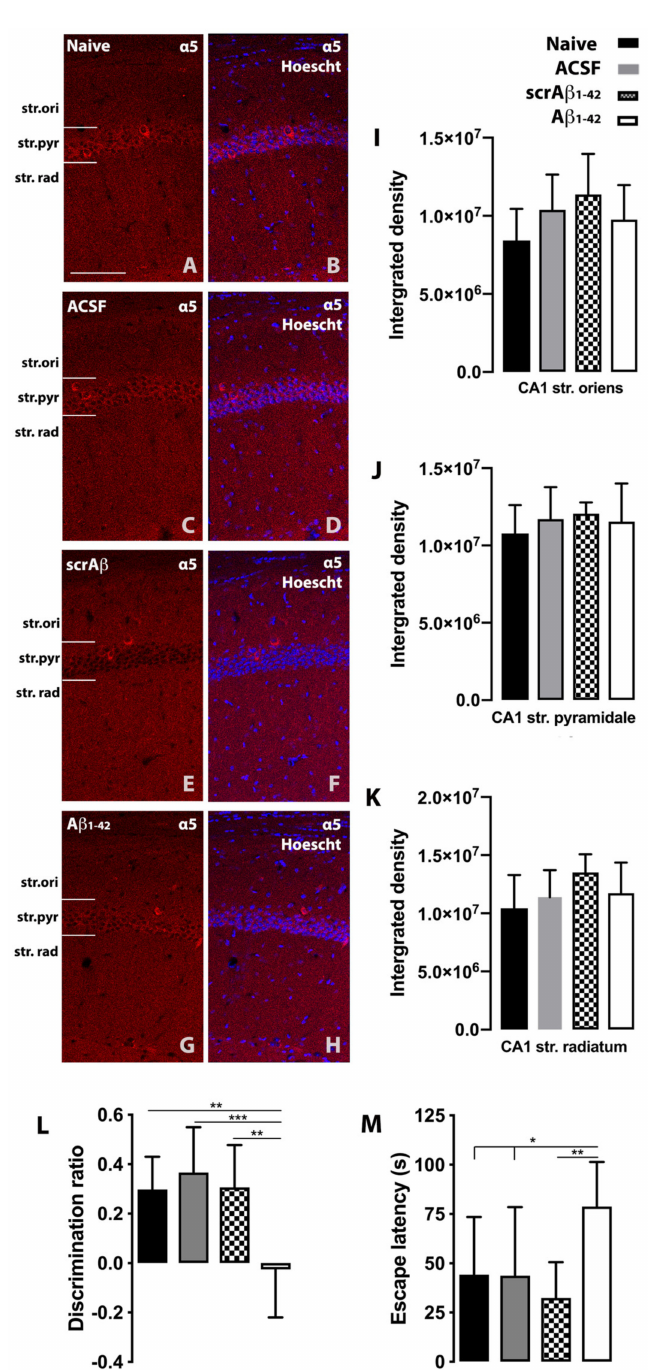
Figure 2. ( A – H ) Representative photomicrographs of the hippocampal CA1 region showing GABA A R α 5 subunit expression (red) and α 5 immunoreactivity overlaid with Hoechst (blue) labeling for representative naïve control, artificial cerebrospinal fluid- (ACSF), scrambled A β 1-42 - (scrA β 1-42 ) and A β 1 − 42 -injected mice (A β 1 − 42 ). ( I – K ) : Quantification of GABA A R α 5 subunit immunoreactivity in the regions and layers of the hippocampus in NC, ACSF-, scrA β 1-42 - and A β 1-42 -injected mice. Scale bar, 50 µ m. ( L,M ) A β 1 − 42 -injected mice show long- and short-term spatial memory impairment revealed by the novel object recognition ( L ) and Water Morris Maze ( M ) tests, respectively. The A β 1-42 -lesioned mice do not discriminate between novel and familiar objects and show longer escape latency in trial 4 of the MWM task. Data are expressed as mean ± SD (one-way ANOVA and Tukey’s post-hoc test (* p < 0.05, ** p < 0.001, *** p < 0.001; NC n = 9, ACSF-injected n = 9, scrA β 1-42 -injected n = 9 and A β 1-42 -injected n =